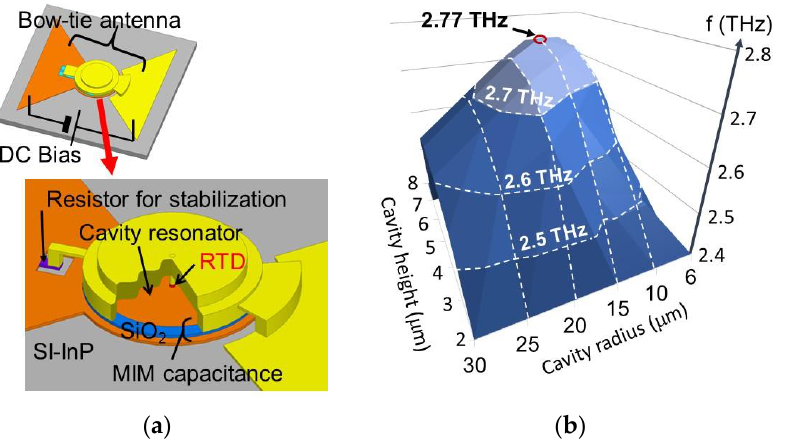
Figure 6. RTD oscillator integrated with cylindrical cavity and bow-tie antenna for high-frequency oscillation [33, 34]: ( a ) Oscillator structure, and ( b ) calculation of oscillation frequency as a function of cavity height and radius. Copyright (2020) The Japan Society of Applied Physics [34].